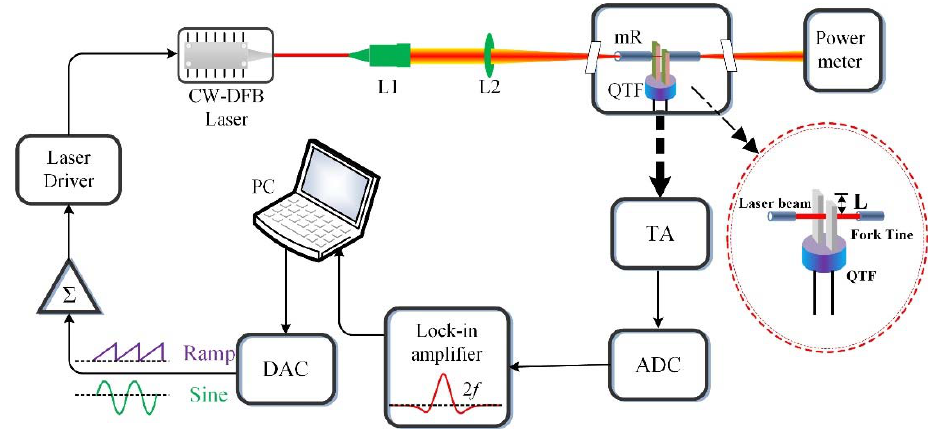
Figure 2. Schematic of the quartz ‐ enhanced photoacoustic spectroscopy (QEPAS) sensor system. Table 1. Dimensions and parameters of the small ‐ gap QTF. Parameter